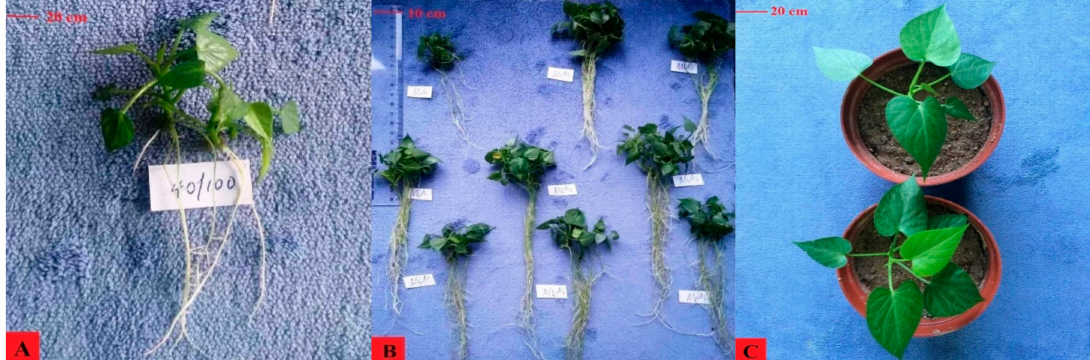
Figure 5. Grown vegetable sweet potato ( Ipomoea batatas L.) plantlets from nodes encapsulated with sodium alginate (4%) and CaCl 2 (100 mM) matrices at five weeks after inoculation ( A ), grown vegetable sweet potato plantlets after acclimatization just before transplanting to pots ( B ), and transplanted vegetable sweet potato plantlets from the encapsulated nodes, two weeks after trans- planting ( C